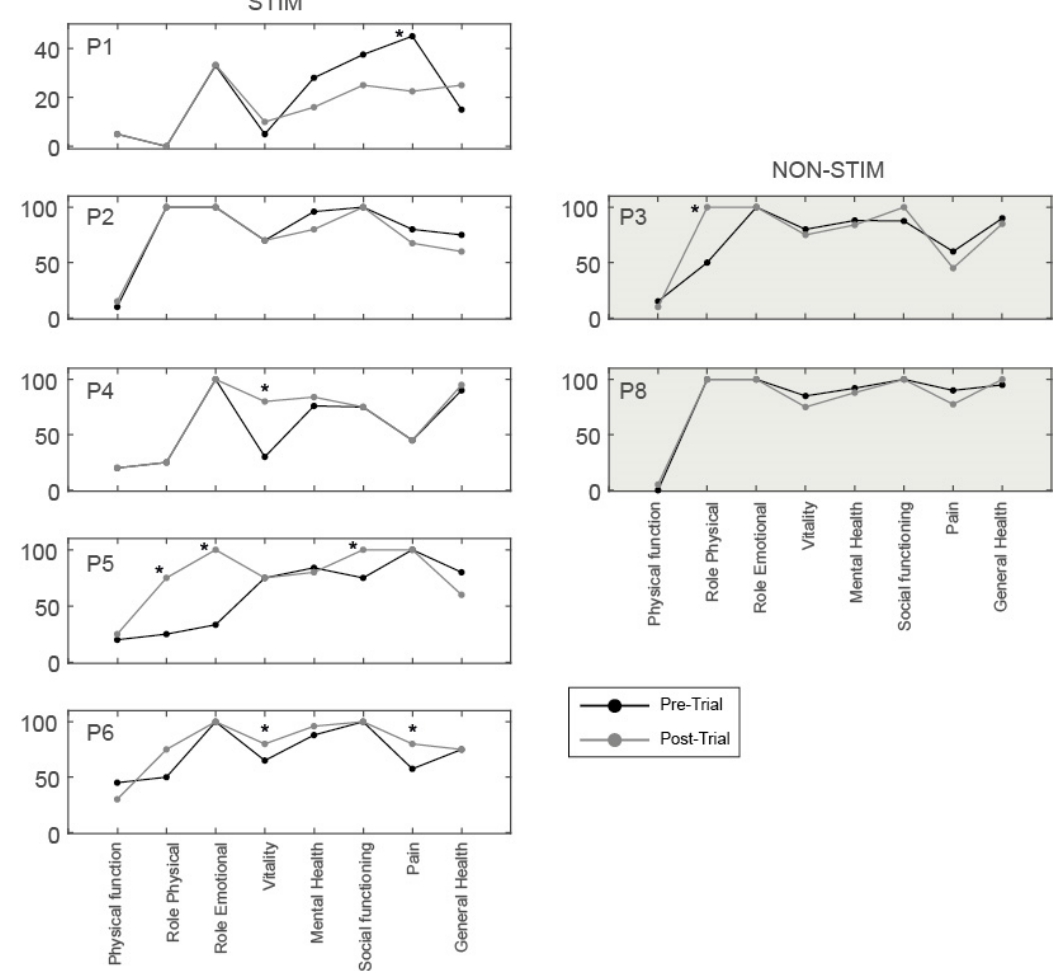
Figure 8. SF-36 scores across 8 sub-categories before (black) and after (grey) the intervention for participants in STIM and NON-STIM groups. * denotes a pre-post intervention change of >MDC for each participant within each sub-category [43].